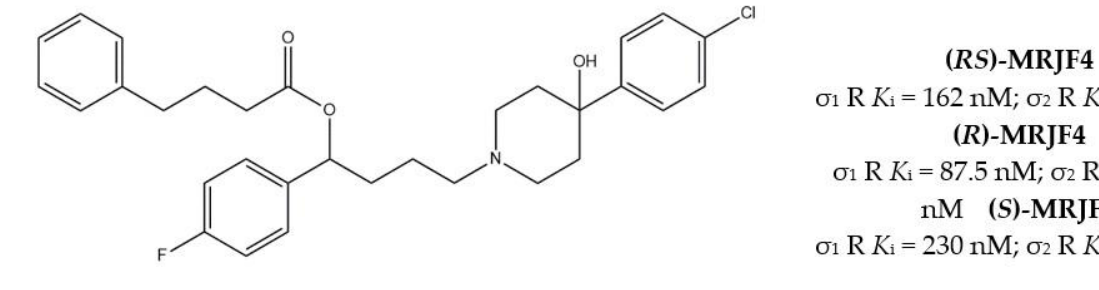
Figure 2. ( RS )-, ( R )- and ( S )-MRJF4 and K i values for σ receptors.